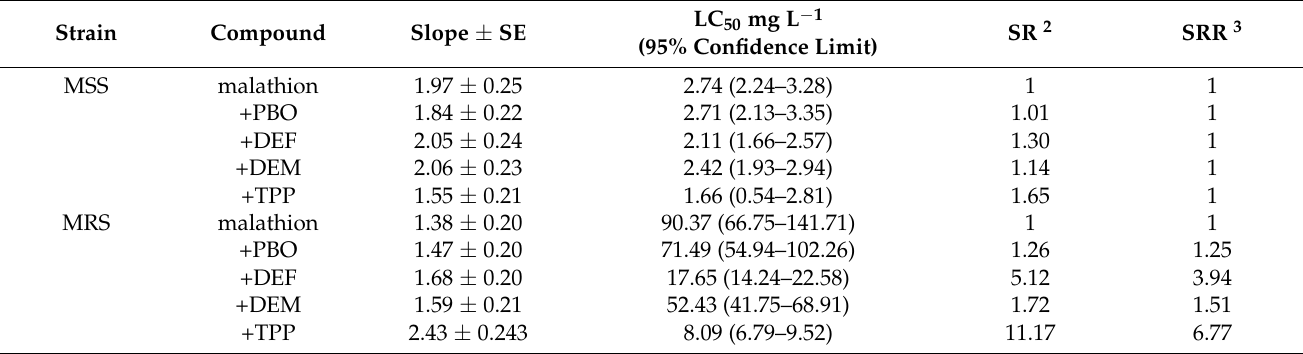
Table 3. Synergism of PBO, DEF, DEM and TPP on malathion in the MRS and MSS strains 1 . Strain